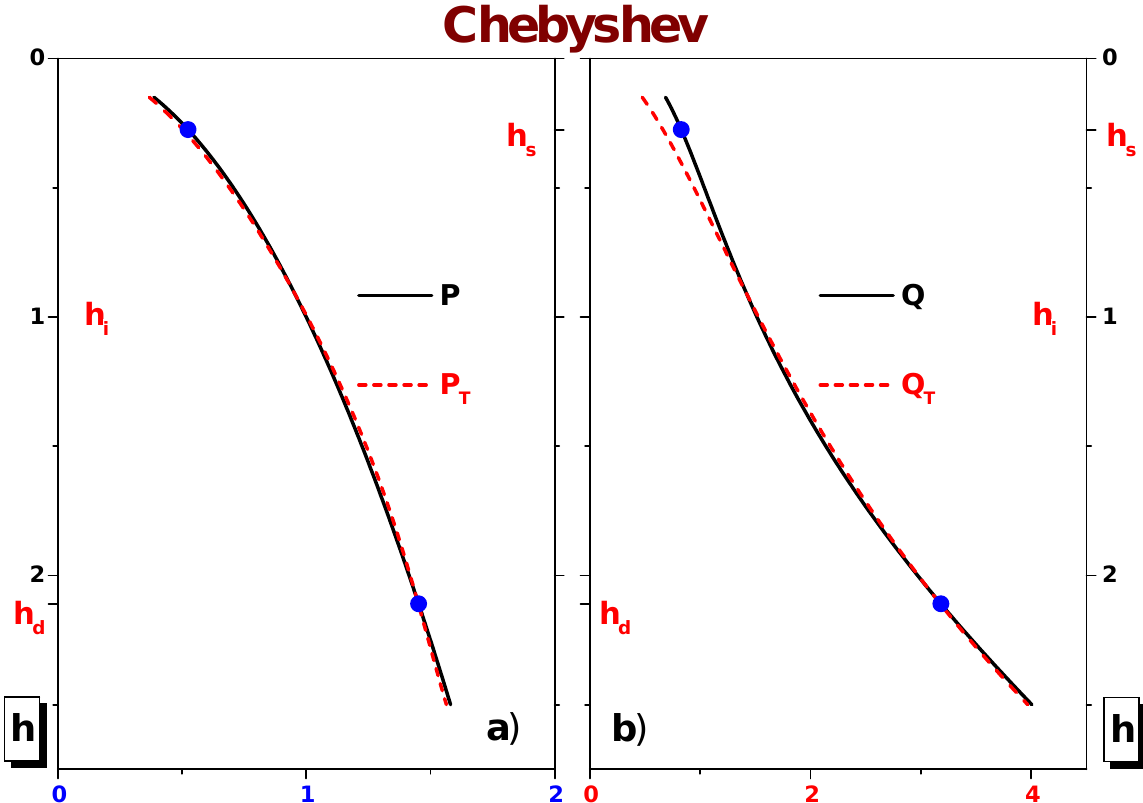
Figure 4. compares in panels a) and b) the expansions in Chebychev polynomials P T P T P T and Q T Q T Q T for the functions PPP and QQQ respectively. Note in a) that P T P T P T fits PPP well in the whole range h s ≤ h ≤ h d h s ≤ h ≤ h d h s ≤ h ≤ h d , while the panel b) shows that Q T Q T Q T also fits QQQ well for depths in deep and intermediate waters, but the difference between Q T Q T Q T and QQQ increases around shallow waters. In both panels, the full dots delimit the range between deep and shallow waters h s ≤ h ≤ h d h s ≤ h ≤ h d h s ≤ h ≤ h d